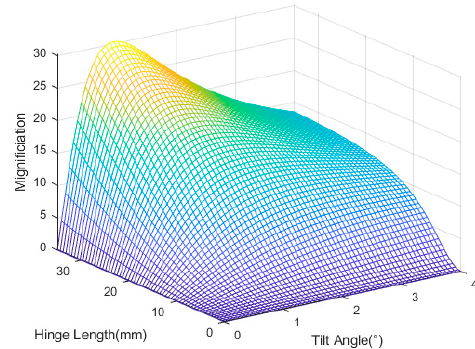
Figure 7. E ff ects of hinge length and tilt angle on Figure 7. Effects of hinge length and tilt angle on magnification.